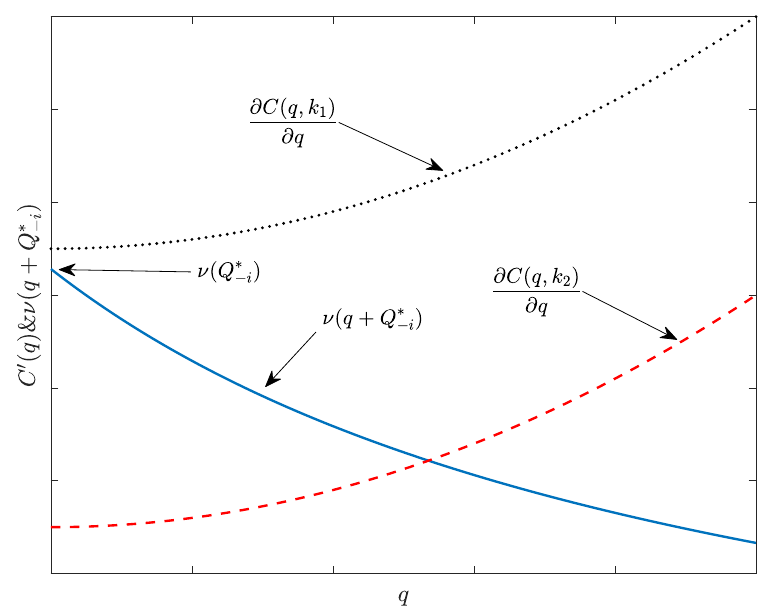
Figure 8. Information Acquisition with Heterogeneous Information